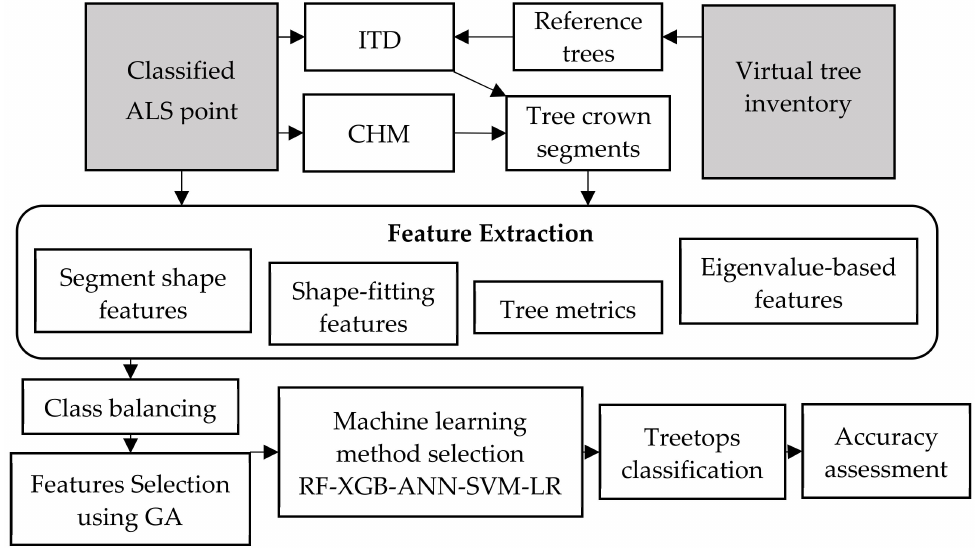
Figure 3. Methodological